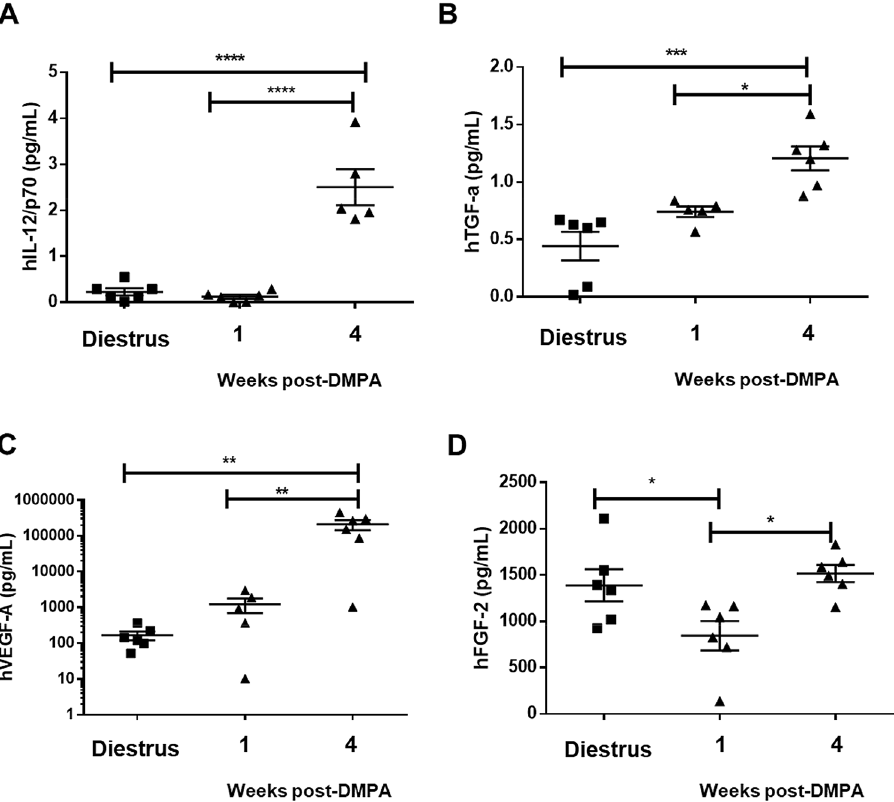
Figure 5. DMPA alters vaginal cytokines in Hu-mice. Cytokines were quantified in the vaginal homogenates of uninfected (never challenged with HIV-1) Hu-mice in diestrus (N = 6) and at 1 week (N = 6), or 4 weeks post-DMPA (N = 6) to determine if DMPA altered vaginal cytokines. The 1 week timepoint corresponds to the time we typically challenge Hu-mice with HIV-1, while the 4 week timepoint corresponds to week 3 of infection, if the Hu-mice had been challenged and infected. ( A ) hIL12/p70 ( P ≤ 0.0001 one-way ANOVA), ( B ) hTGF-α ( P = 0.0003 one-way ANOVA), and ( C ) hVEGF-A ( P = 0.0029 one-way ANOVA) were significantly greater in Hu-mice at 4 weeks post-DMPA as compared to 1 week post-DMPA and diestrus. ( D ) hFGF-2 ( P = 0.0125 one-way ANOVA) was significantly suppressed at 1 week post-DMPA as compared to 4 weeks post-DMPA